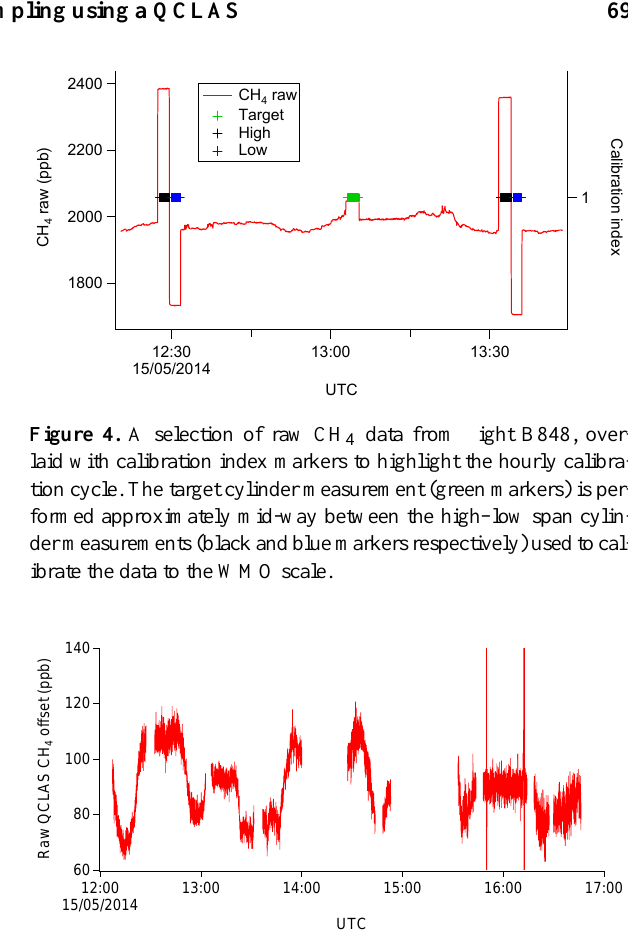
Figure 5. The offset between the raw QCLAS CH 4 data and the calibrated FGGA data (used here as our reference) during flight B848. Gradients of over 30ppb in less than 10min can be seen to be